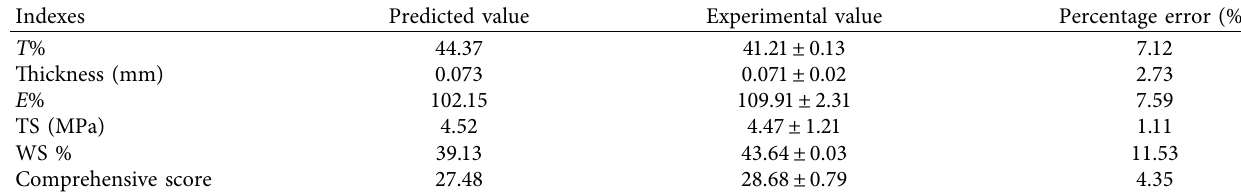
Figure 2: 3D responses surfaces. Table 7: Predicted and experimental data for the responses at the optimum